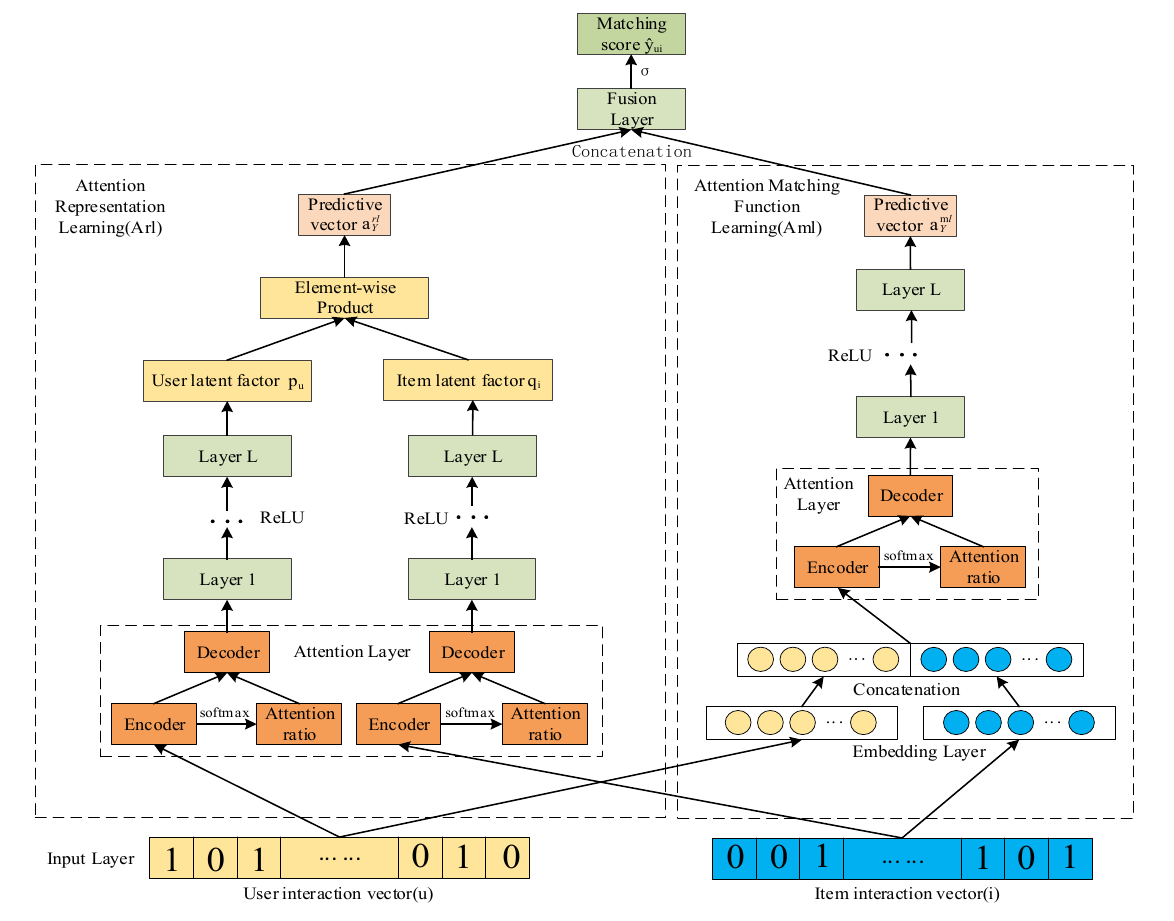
Figure 2. The framework of DACR.